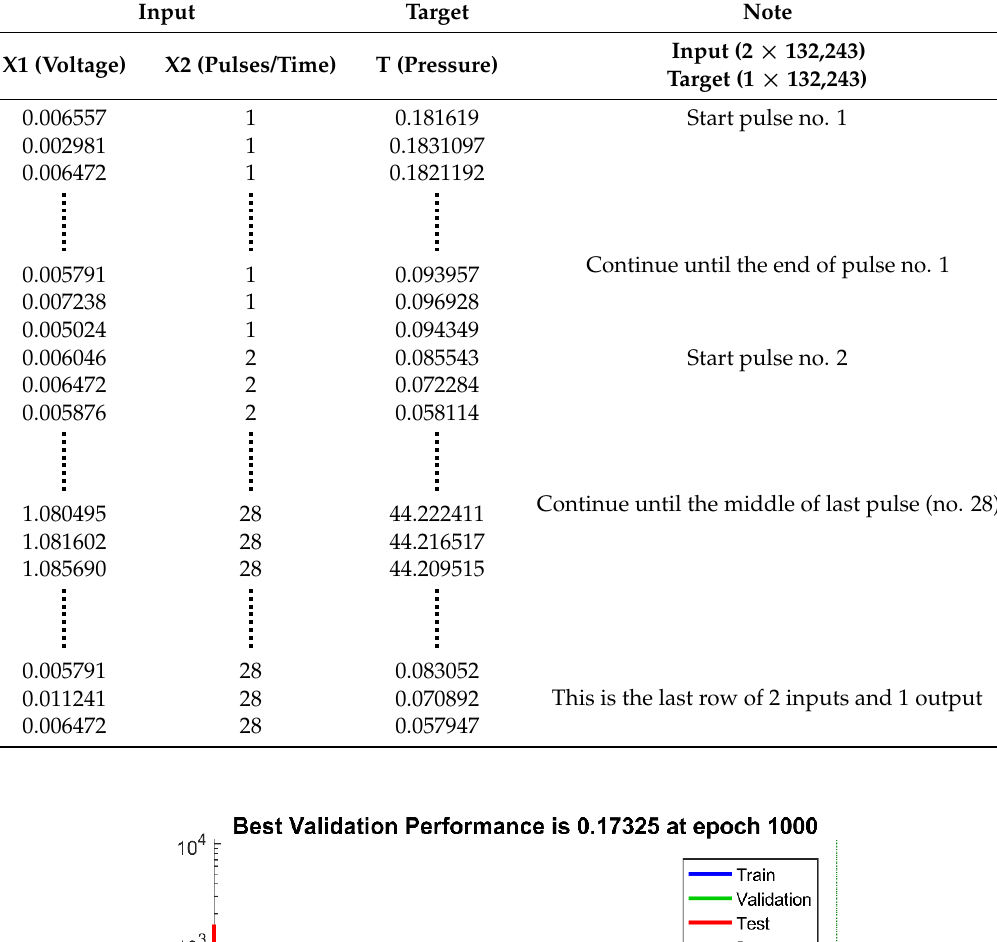
Table 2. The inputs and target data set used for neural network training.